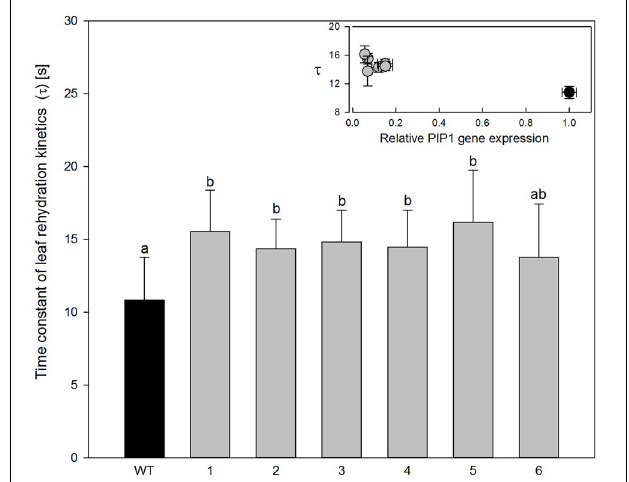
FIGURE 5 | Time constant of leaf rehydration kinetics for wild-type and transgenic lines. Data are means of 6–12 leaves for each line; the error bars represent SD. There were significant differences between wild-type and transgenic poplars at P < 0 . 05 according to variance analysis. Letters denote homogeneous groups based on Fisher LSD method corrected for the multiple comparisons. Inset figure; time constant values were plotted for PIP1 relative expression. Bars denote SE. Black circle, wild-type plants; gray circles, transgenic